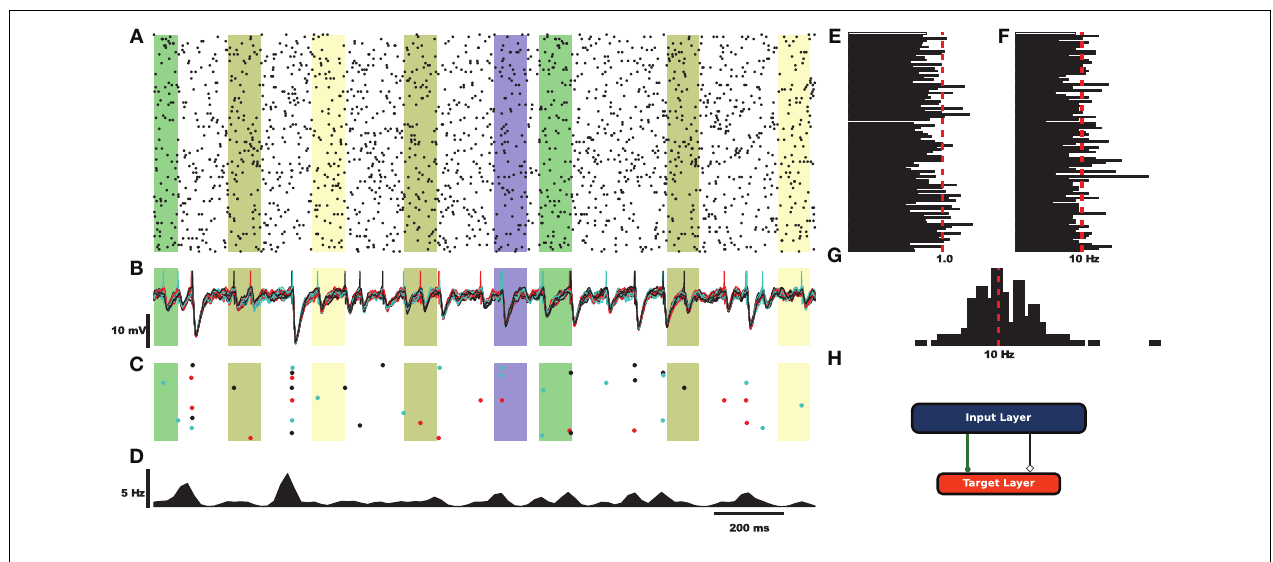
FIGURE 1 | Example analysis of simulated data using a derived voltage input class. For this example the rectangular bars highlight regions where different signals are injected into the network. (A) Raster plot of 100 cells selected from the input layer. (B) Voltage traces of the target layer neurons. (C)